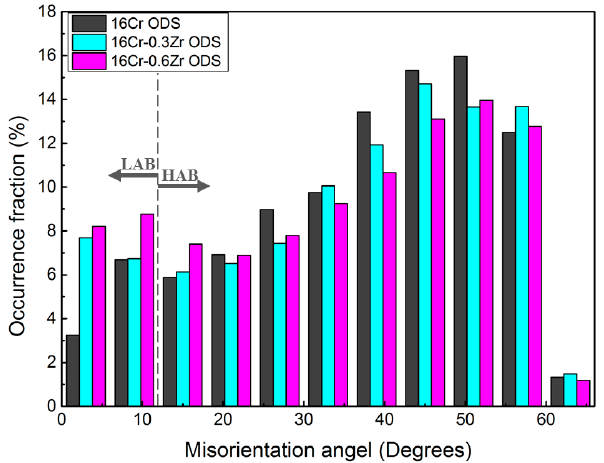
Figure 3. Grain misorientation distribution of three ODS steels.